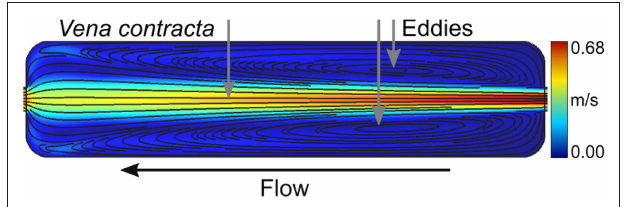
FIGURE 1 | Separated flow and eddies. Flow simulation of a 2 mL/min flow rate through a rectangular imaging slit without diffusers. Streamlines are shown in black and are overlaid on the velocity field with values indicated by the color bar. The formation of a vena contracta and eddies are made evident with the separation of the flow. The flow direction is specified with the black